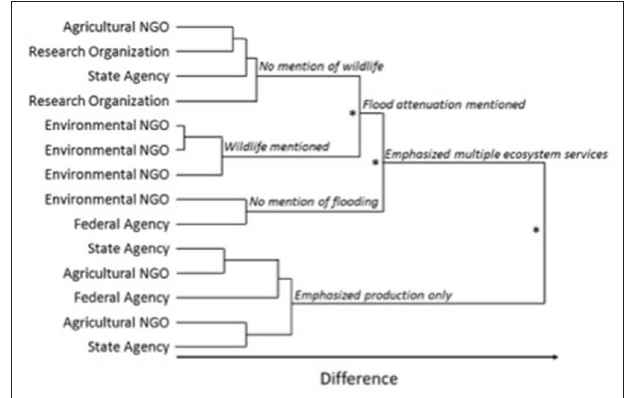
FIGURE 1 | Dendrogram illustrating agglomerative clustering based on Spearman correlation of preferred ecosystem services. NGO, non-governmental organization. Stars (*) indicate major points of